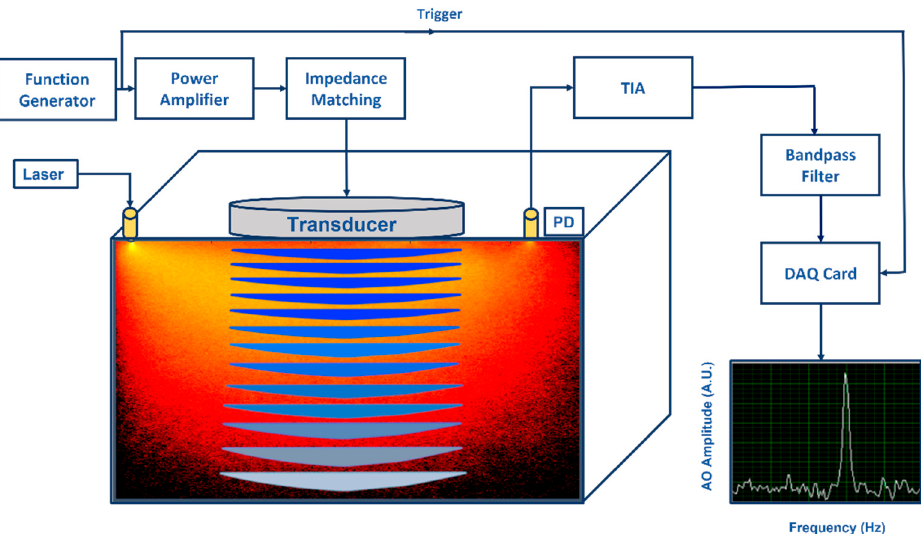
Figure 1. An illustration of an acousto − optic detection system: Acoustic part: Function generator generates amplitude modulated signal at fixed frequency (kHz) and power amplifier drives the ultrasonic transducer. Acoustic waves generated by the transducer propagate into the substance causing pressure changes in the substance. Optical part: Light illuminated by a laser propagates into the substance and a part of the diffused photons pass through the ultrasonic modulated areas causing light modulation to these photons due to the acousto − optic effect. A photo detector (PD) converts optical power to photocurrent (both DC and AC) and the transimpedance amplifier (TIA) converts it to voltage. When voltage signal is effectively filtered by a narrow bandpass filter at the fixed frequency, modulated light can be distinguished visible as a narrow power peak in frequency domain.